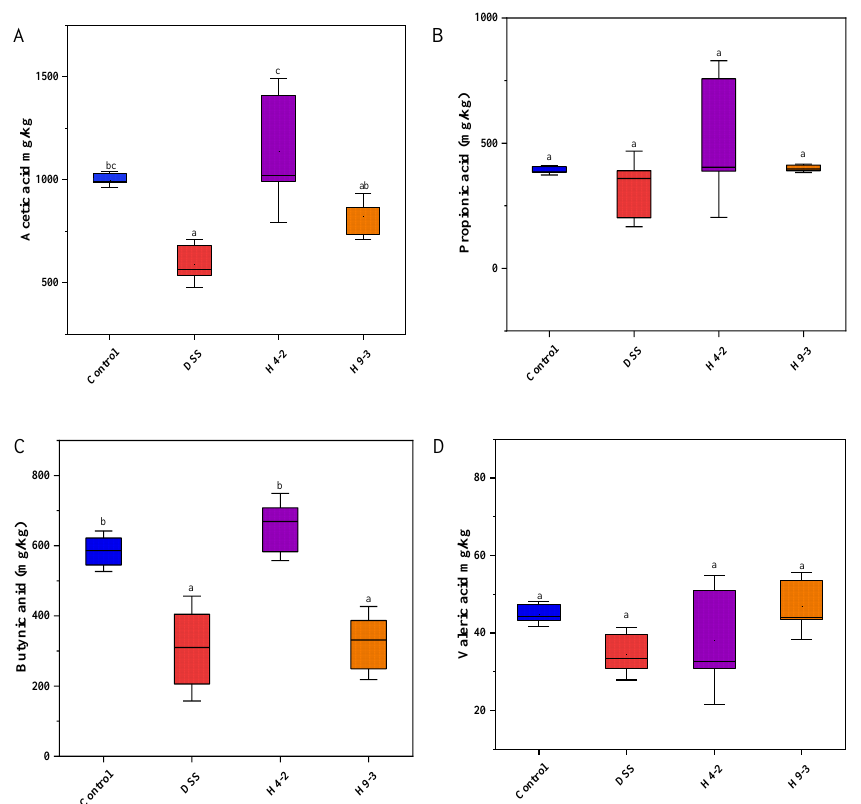
Figure 8. The concentrations of acetic acid ( A ), propionic acid ( B ), butyric acid ( C ) and valeric acid ( D ) in mouse intestine. Different lowercase letters above the columns indicate significant differences ( p < 0.05), and the same superscript letters indicate that the differences between the values are not statistically significant ( p > 0.05).